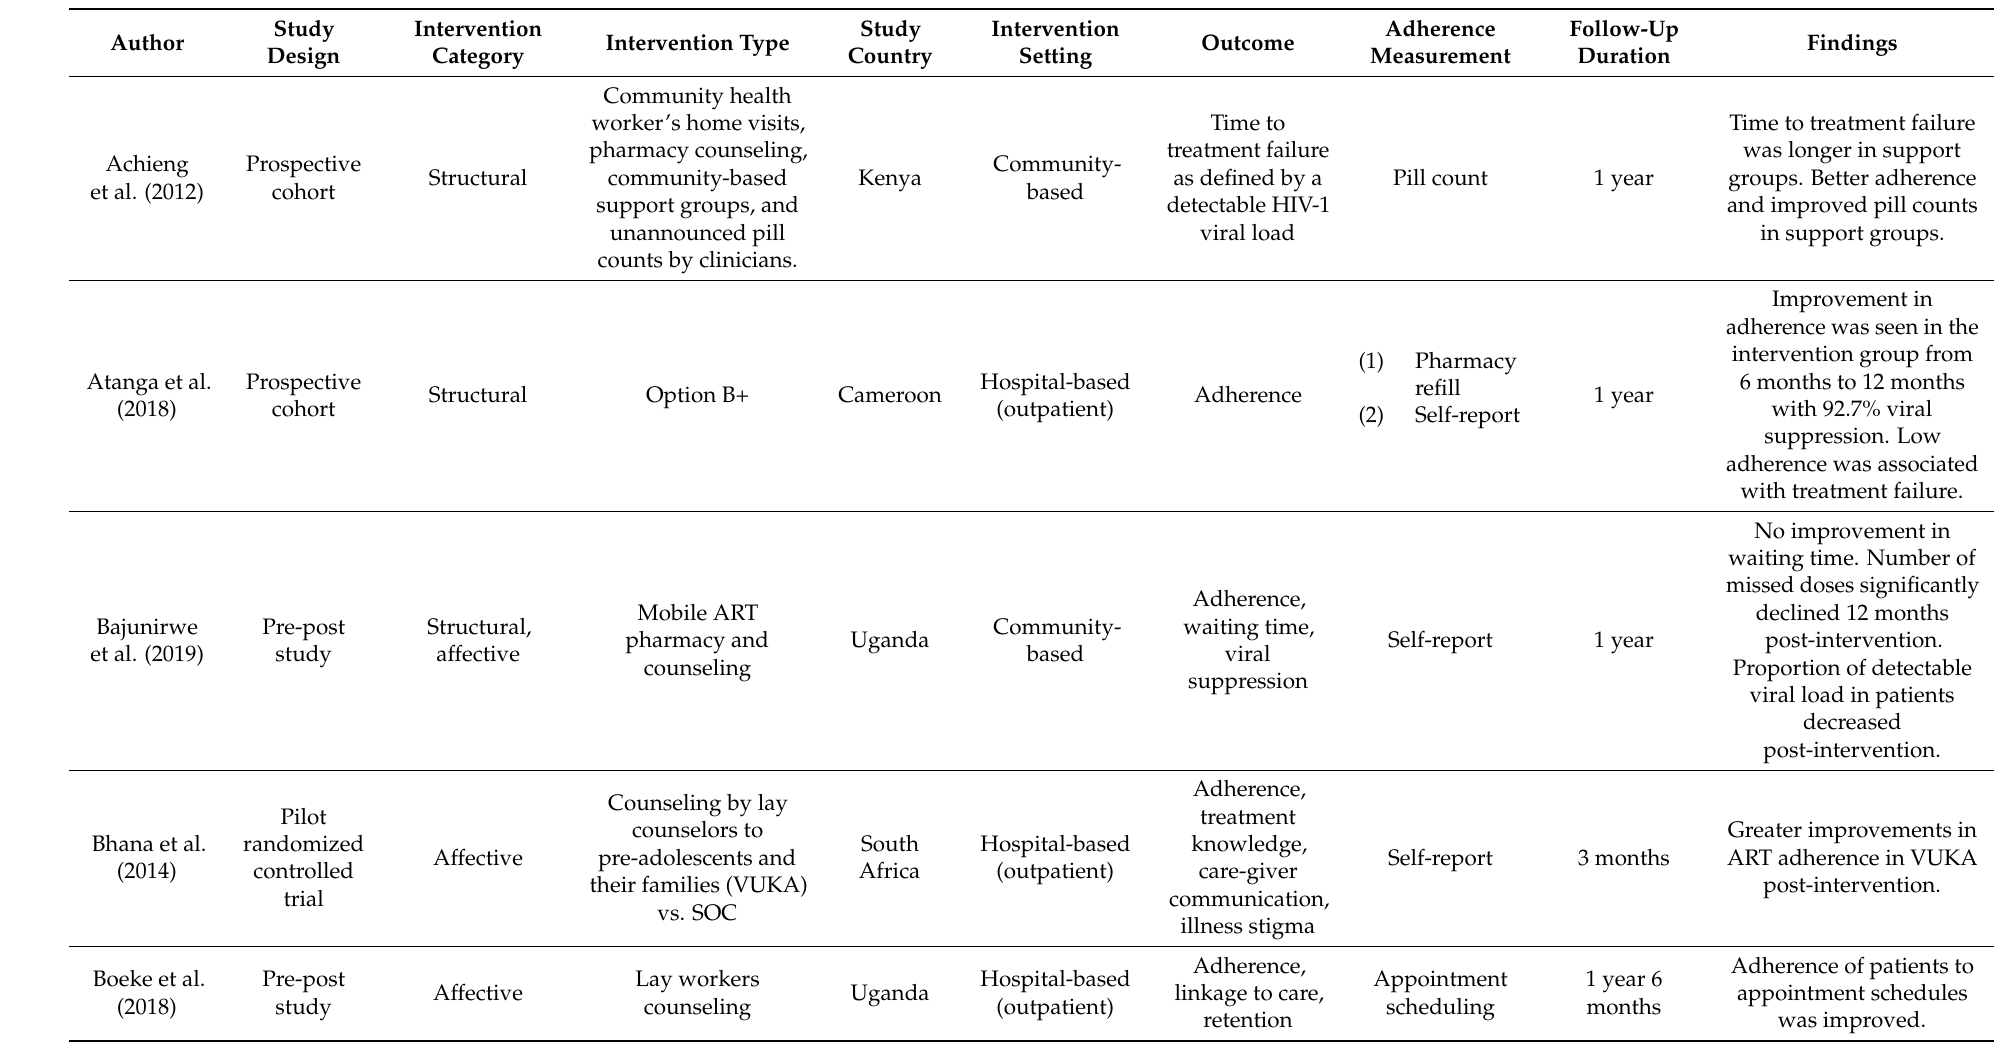
Table 1. Summary of characteristics of interventions on ART adherence in sub-Saharan